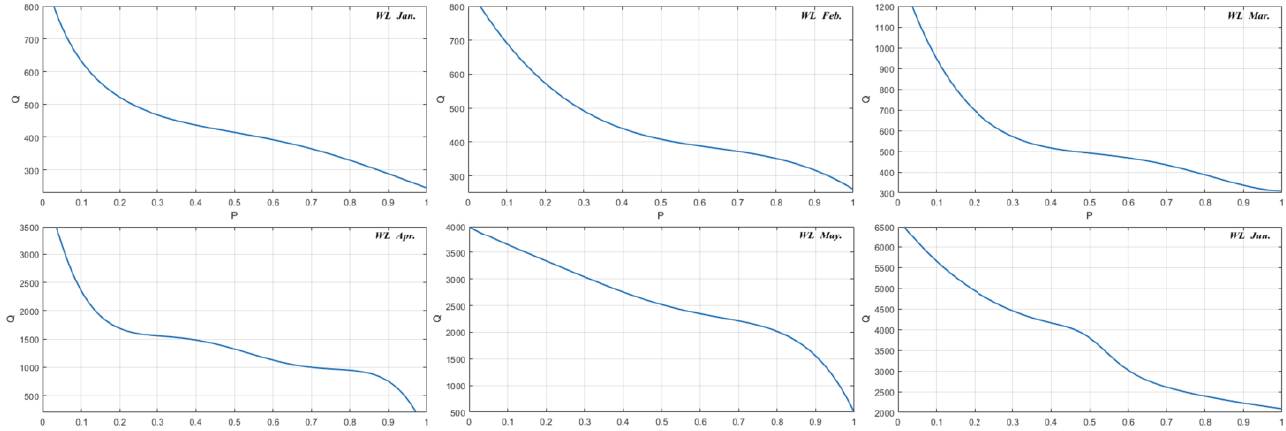
Figure A4. Monthly fitted FDC of Wulong section. Table A7. Fit type and equation form of Wulong section. Month